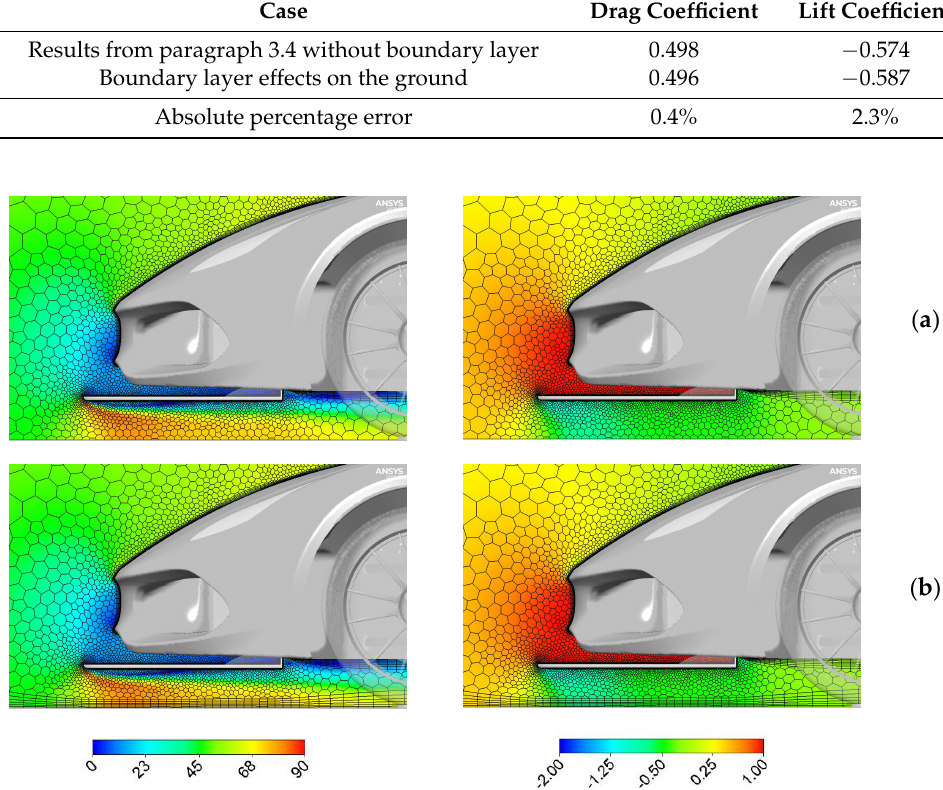
Table A1. Comparison of aerodynamic coefficients with and without boundary layer forming on the ground.